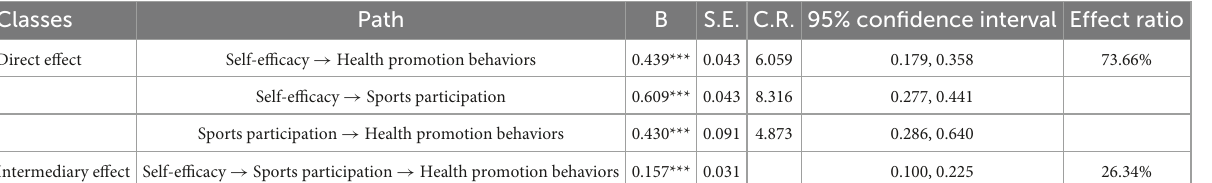
TABLE 5 Hypotheses model path and effect decomposition.